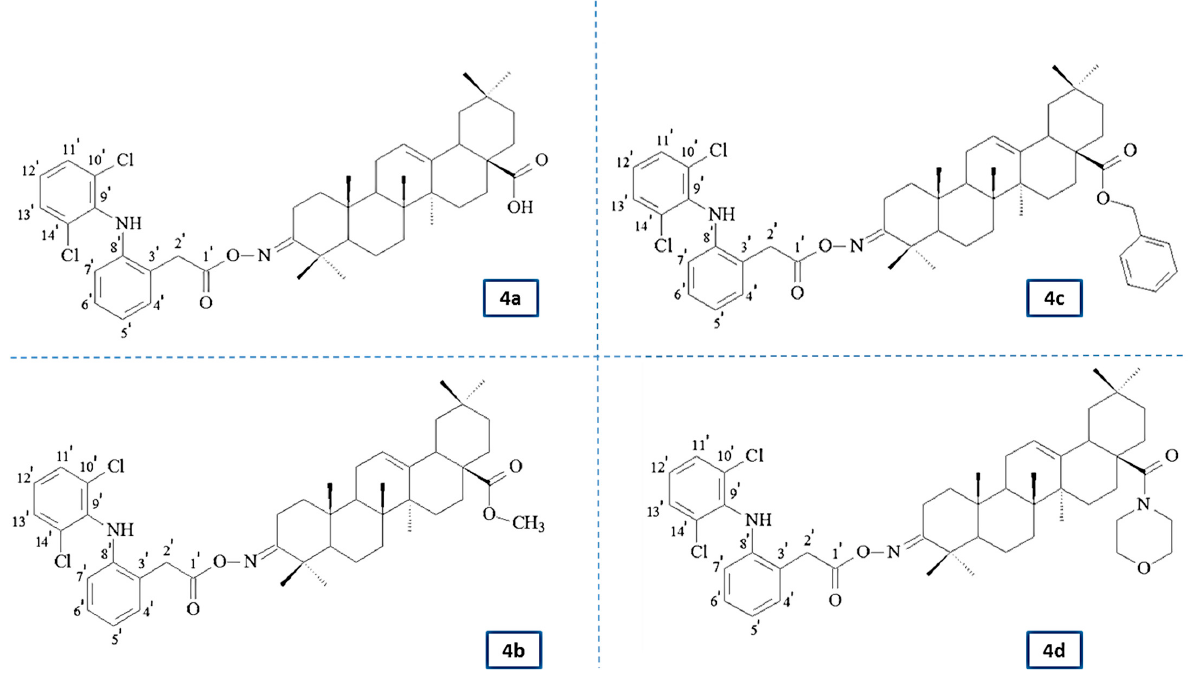
Figure 1. The chemical structures of the investigated novel oleanolic acid oxime derivatives with diclofenac (DCL–OAO) ( 4a – 4d ); ( 4a ) 3 ‐ diclofenacoxyiminoolean ‐ 12 ‐ en ‐ 28 ‐ oic acid; ( 4b ) 3 ‐ diclofenacoxyiminoolean ‐ 12 ‐ en ‐ 28 ‐ oic acid methyl ester; ( 4c ) 3 ‐ diclofenacoxyiminoolean ‐ 12 ‐ en ‐ 28 ‐ oic acid benzyl ester; ( 4d ) 3 ‐ diclofenacoxyiminoolean ‐ 12 ‐ en ‐ 28 ‐ oic acid morpholide.